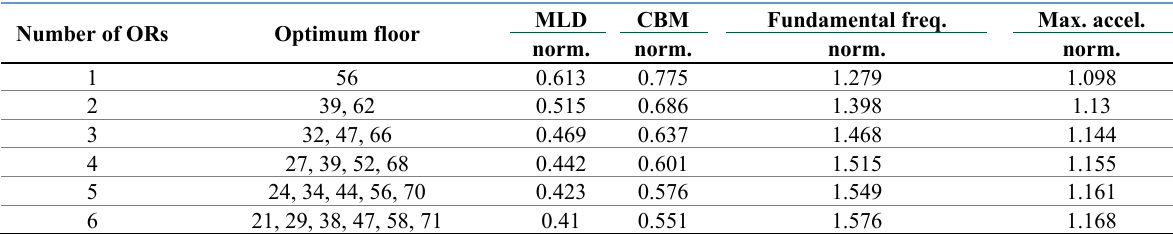
Table 1. Results of single-objective optimizations for MLD (OR) Number of